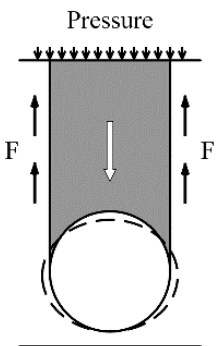
Figure 1. Mechanism of soil arching within the soil-pipe system.